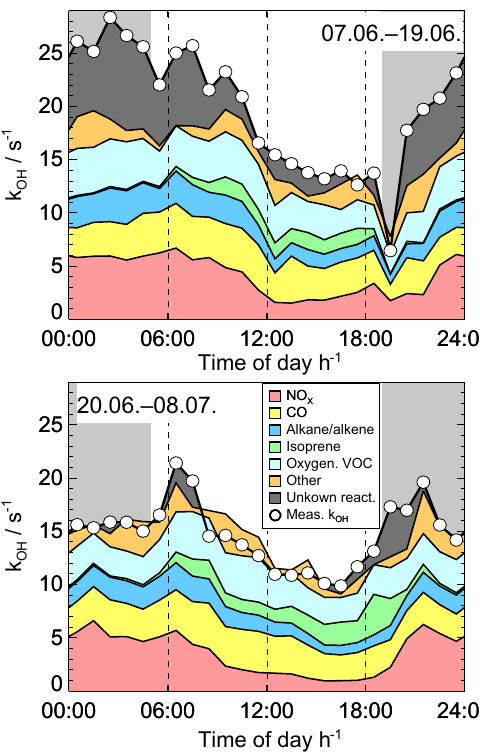
Figure 6. Sum of median diurnal profiles of reactivities from all measured OH reactants compared to the measured OH reactivity for the first and second part of the campaign. Data are only included if all major OH reactants and OH reactivity were measured con- currently. “Other” includes small contributions from measured OH reactants listed in Table 1 (CH 4 , SO 2 , aromatics). The dark gray area indicates missing OH reactivity from unmeasured OH reac- tants. Light gray areas indicate